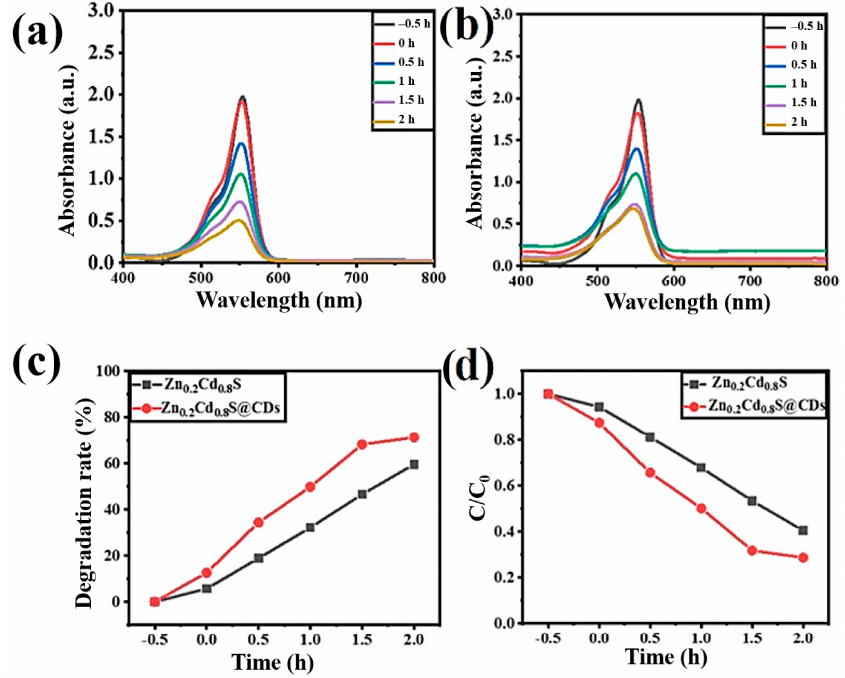
Figure 6. The intensity of the absorption peaks of RhB dye in the presence of Zn 0.2 Cd 0.8 S@CDs ( a ) and Zn 0.2 Cd 0.8 S ( b ) varies with time. ( c ) The degradation rate of RhB varies with time under the action of catalysts. ( d ) The concentration rate of RhB varies with time under the action of catalysts.